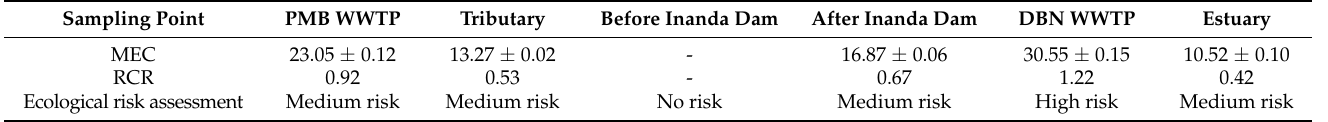
Table 4. Ecological risk assessment of C61-PCBM in sediments from MEC and HONEC obtained realistic conditions. Sampling